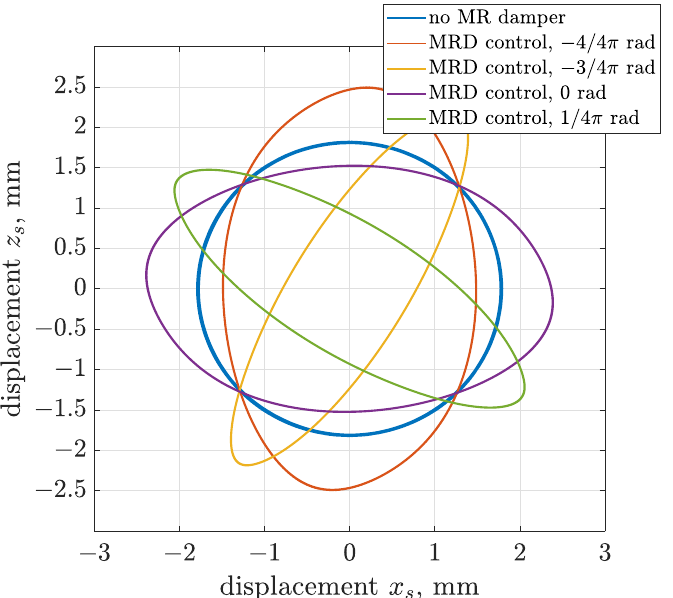
Figure 25. Different configurations of phase shift ∆ α alg dedicated to semi-active generation of linear trajectories of vibration displacement using the dissipative domain of the Bouc–Wen MR damper